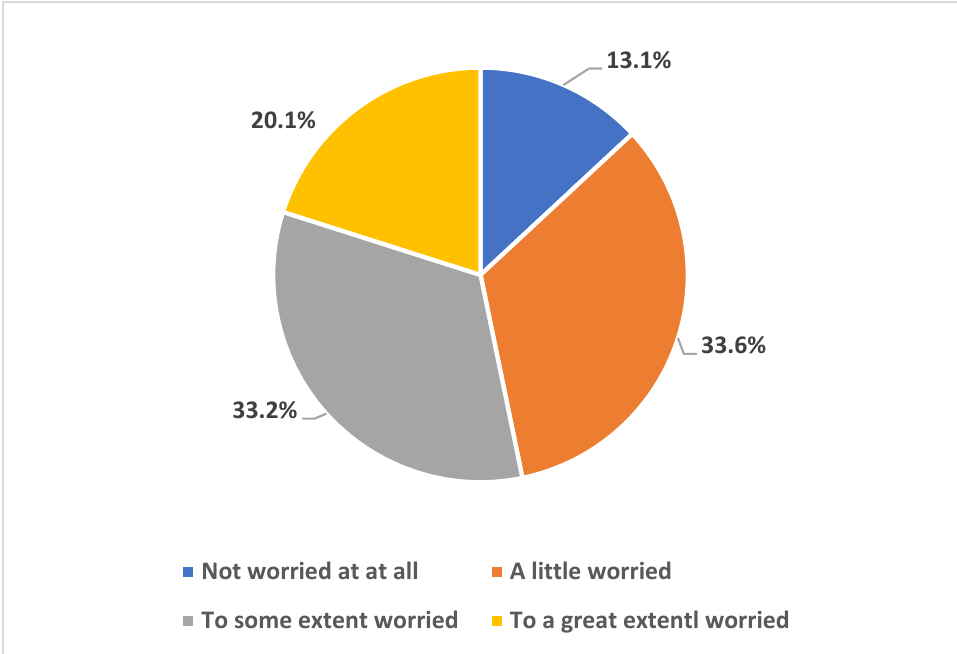
Figure 3. Participants’ worry level of Mpox causing worldwide pandemic such as COVID-19. The healthcare workers’ sources of information and updates about Mpox disease were as follows: 57.3% relied on local MOH website for released information, 68.3% relied on international health websites, such as the WHO and Center for Disease Control and prevention (CDC), another 48.2% of the workers used social media information, and 30.7% relied on scientific journal information as sources of Mpox disease information (Figure